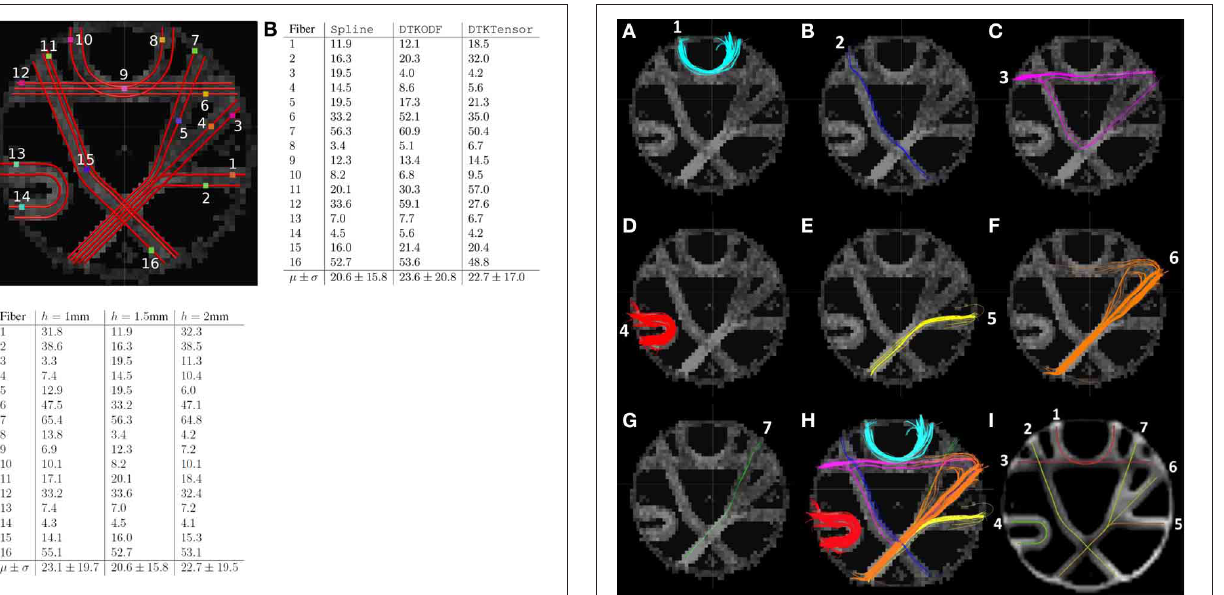
FIGURE 10 | (A–G) Individual fibers (1–7) extracted using our Spline method. (H) Fibers 1–7 extracted using our Spline method. (I) The